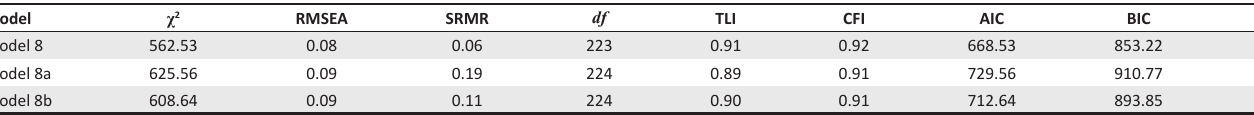
TABLE 6: Fit statistics of competing structural models. Model